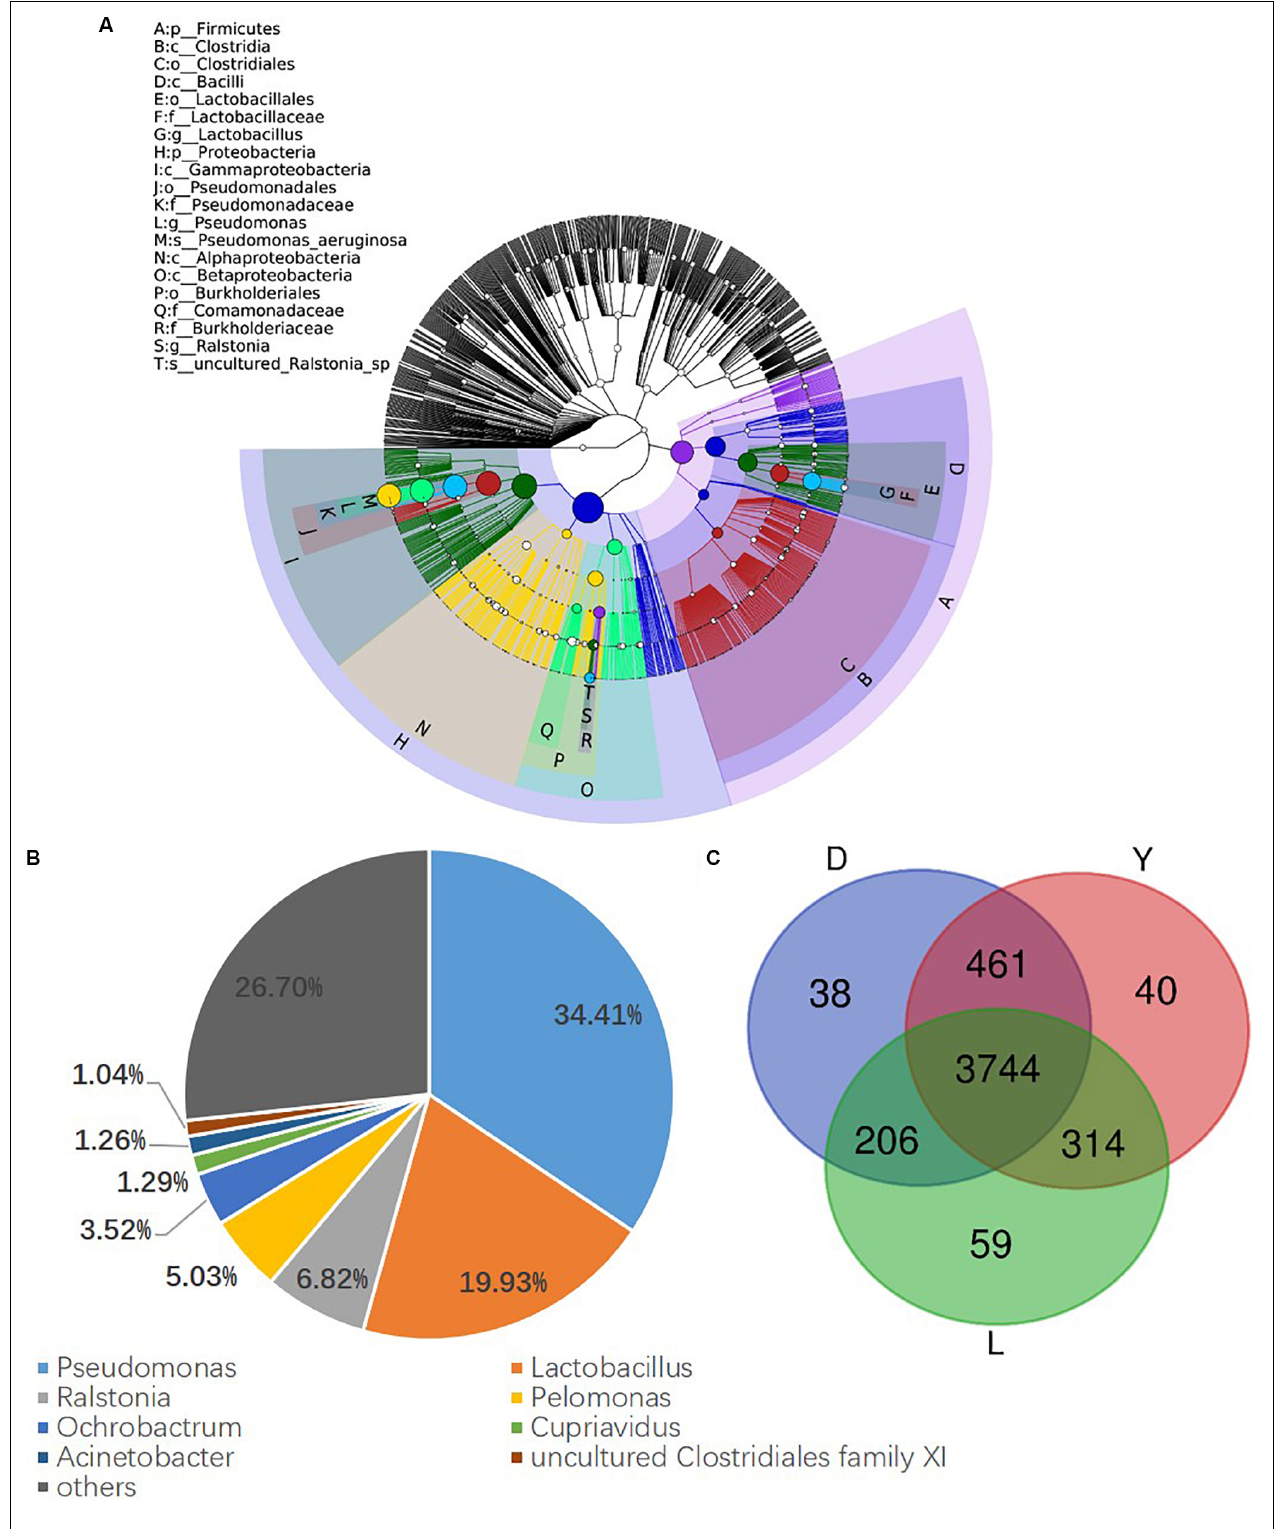
FIGURE 2 | Phylogenetic tree of the taxa and bacterial composition of ejaculated semen. (A) Phylogenetic tree generated using GraPhlAn. The outermost circle represented phyla, and the inner circle represented genera. (B) Bacterial composition at genus level in semen. (C) Venn diagram of semen OTUs in different breed of boars. D, Duroc; L, Landrace; Y,